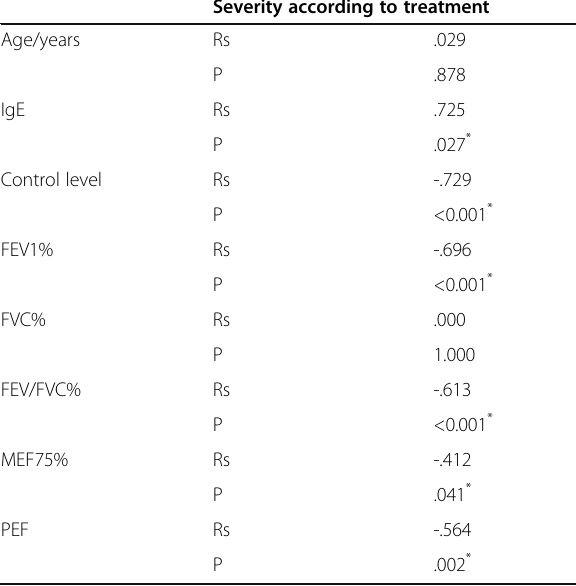
Table 4 Correlation between severity grade in relation to pulmonary function tests and age, serum IgE, and asthma control among cases sensitive to HDM